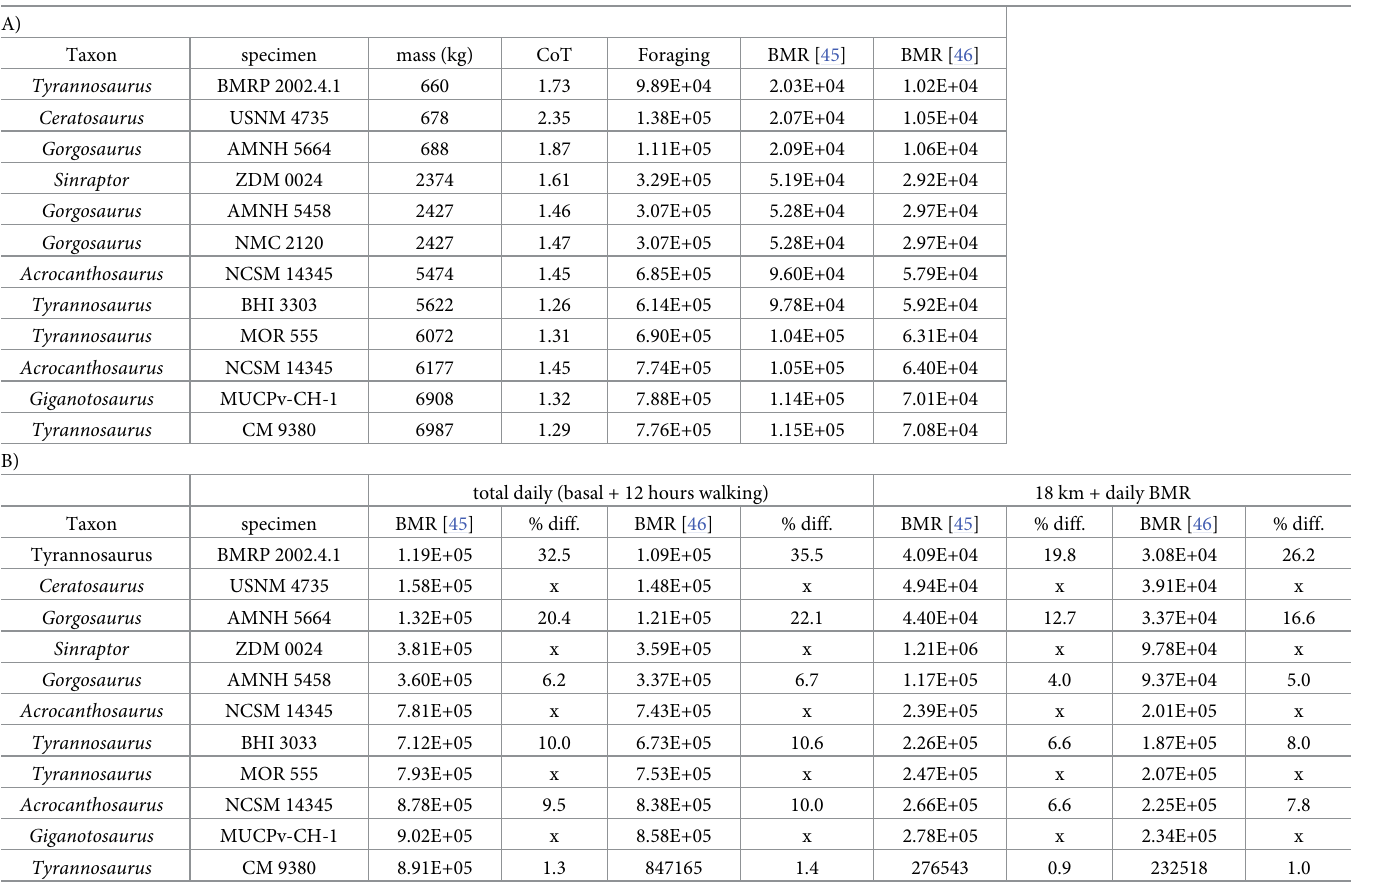
Table 3. Total daily energy expenditure estimates for medium and large